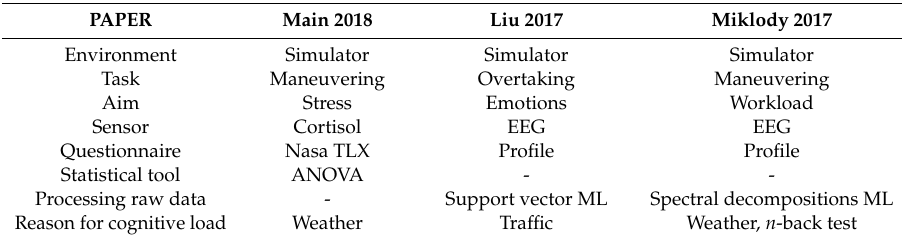
Table 2. Direct workload assessment.